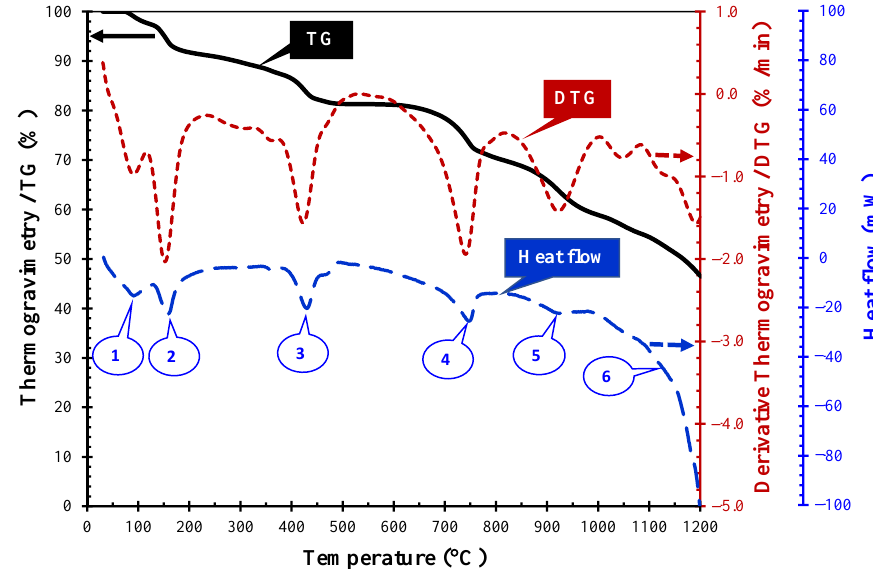
Figure 4. TG-DTA results for natrojarosite residues with a heating rate 10 °C/min.